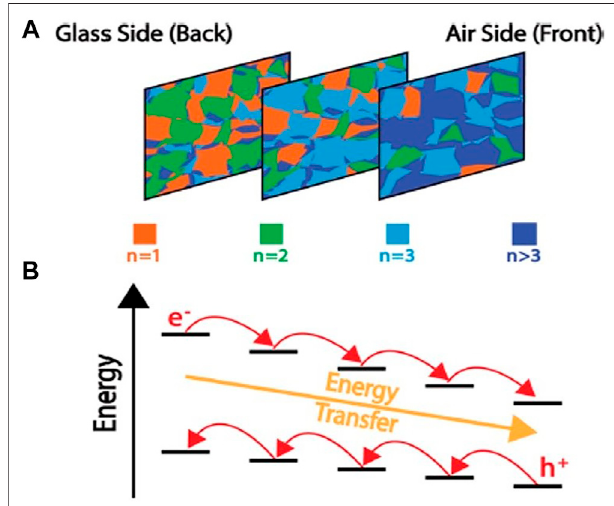
FIGURE 6 | (A) Concentration gradient of quantum wells (QWs) throughout a fi lm of layered perovskite is depicted here. The glass edge of the perovskite fi lm is highly populated with the smallest QWs and the air edge is mostly dense with the thickest QWs. (B) Schematic diagram describing the down-hill energy transfer cascade. Excitonic resonances of the quantum wellsdecreasewiththeincreaseinthickness.Thedirectionofelectrontransfer is the same as that of energy transfer, as compared to the holes which are moving toward the states of higher energy. The fi gure is reprinted with permission from Williams et al. (2019), copyright 2019, American Chemical